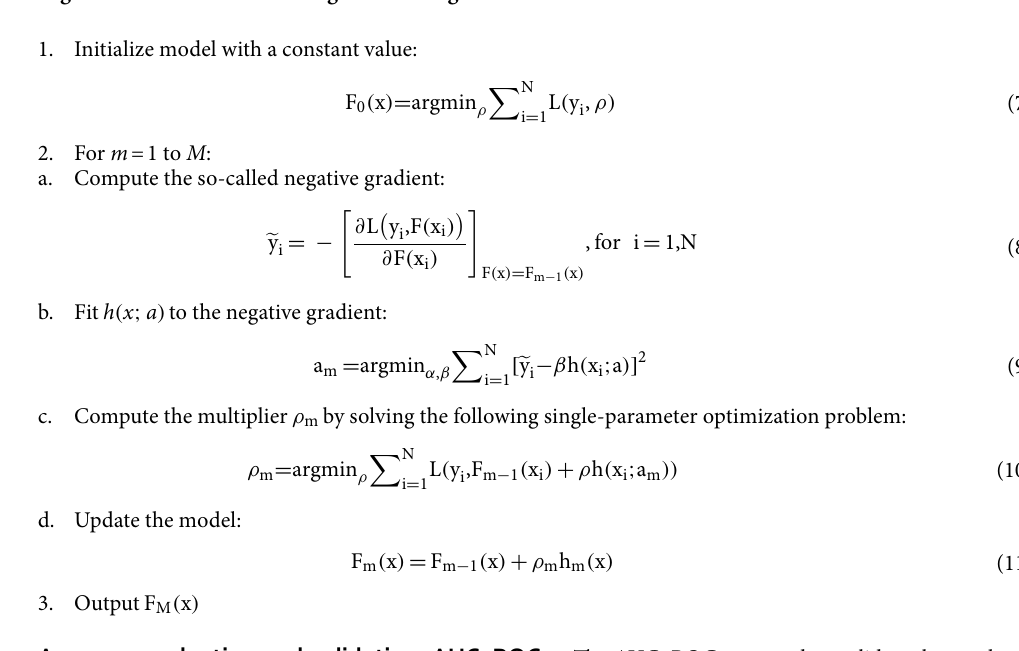
Algorithm 1. Gradient boosting classifier algorithm.